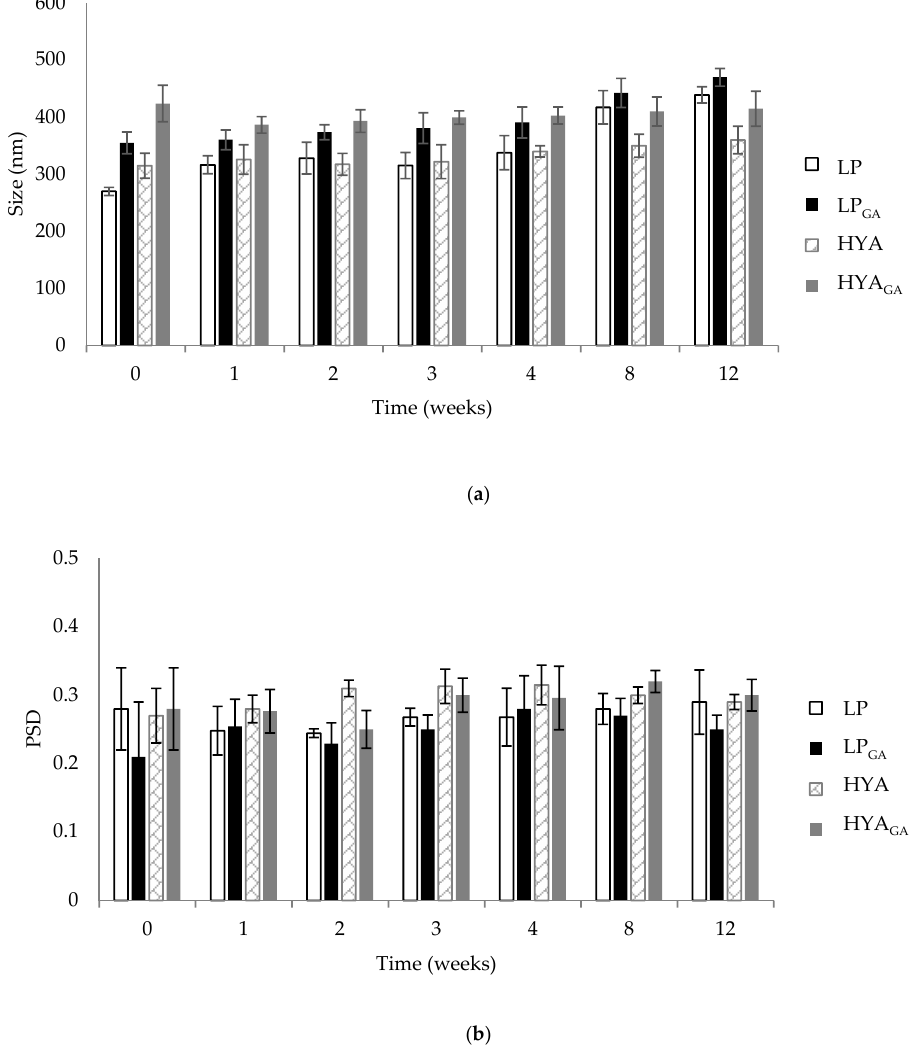
Figure 1. Variation of size ( a ) and particle size distribution (PSD) ( b ) of unloaded and loaded liposomes (LP) and hyalurosomes (HYA) during 12 weeks of storage at 4–8 °C (mean ±SD, n = 3). GA, glycyrrhetinic acid.